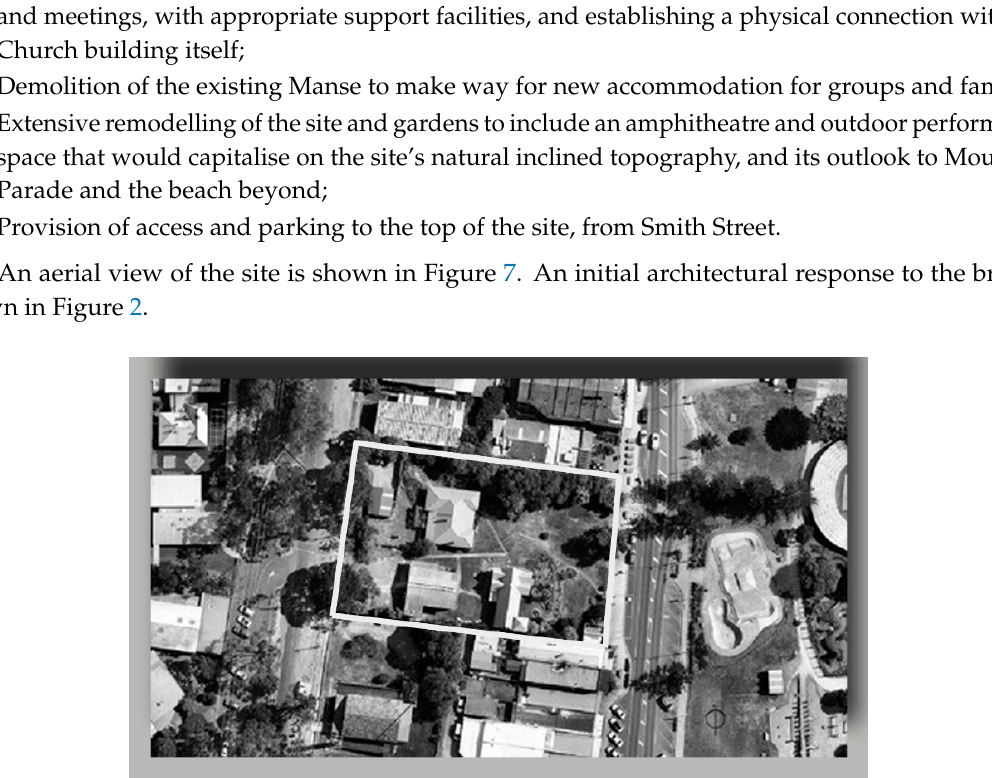
Figure 7. Aerial view of the Lorne Uniting Church site. Source: www.nearmap.com.au [32]. Commons